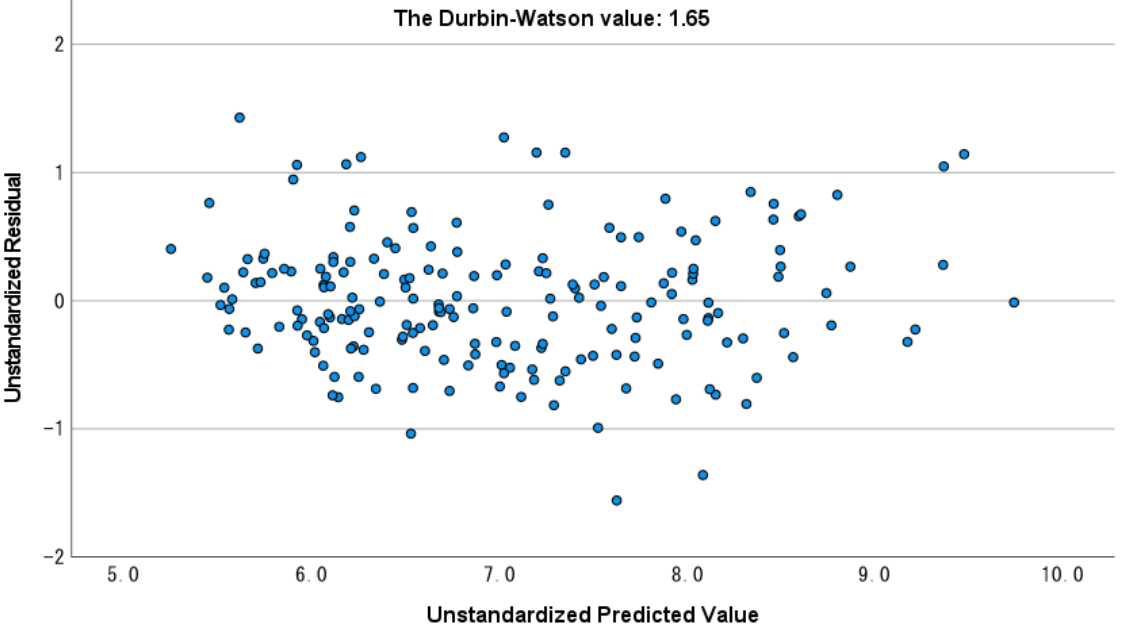
Table 3. Multivariable analysis by stepwise multiple regression analysis.